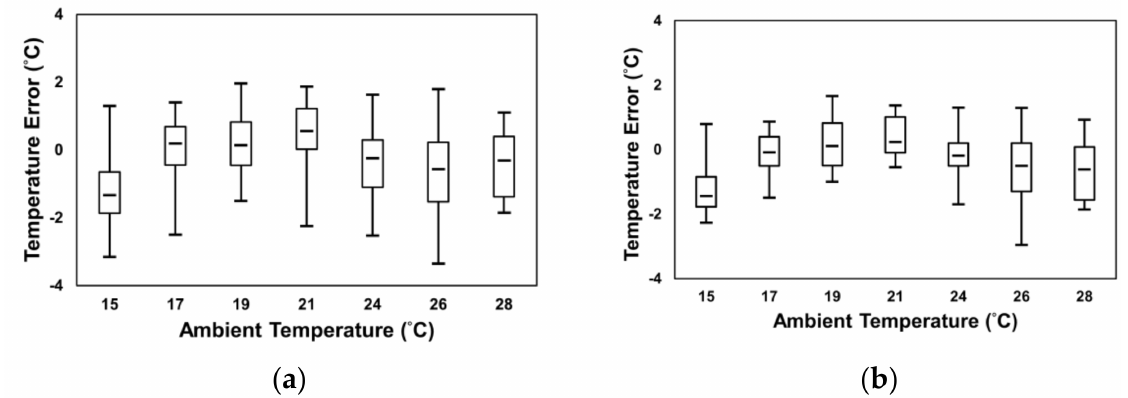
Figure 11. Temperature error versus the ambient temperature ( a ) before ( b ) after IRT frame